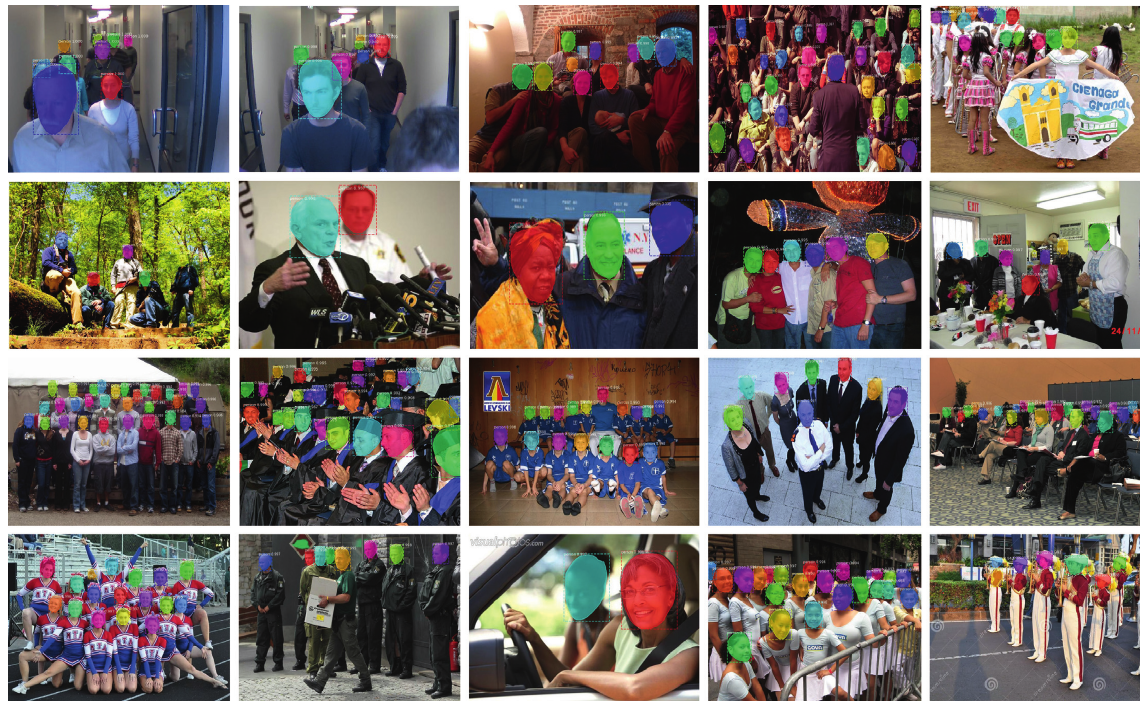
Figure 9: More results of G-Mask